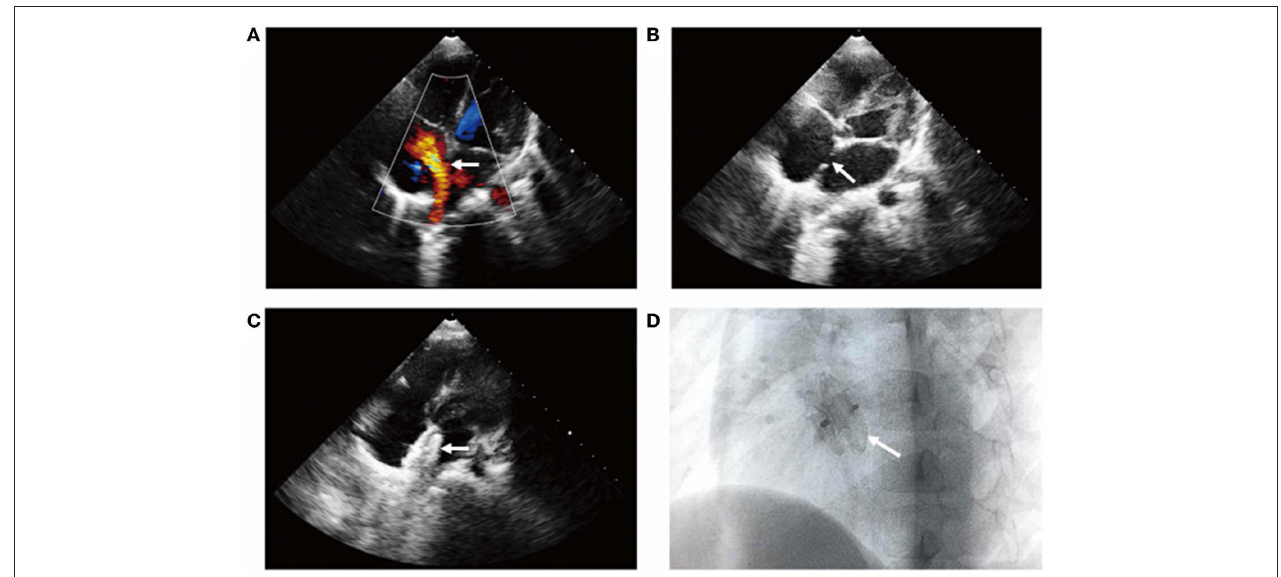
FIGURE 2 | Transcatheter closure of ASD shown by transthoracic color Doppler echocardiography. The apical four-chamber section showed (A) left to right shunt at the level of atrial septum, (B) the continuous interruption of the atrial septum with a loss of about 14mm, and (C) the atrial septal occluder was well-positioned without residual shunt (see arrow). (D) X-ray examination of left anterior oblique position after interventional closure showed that the occluder was fixed and the shape was normal (see